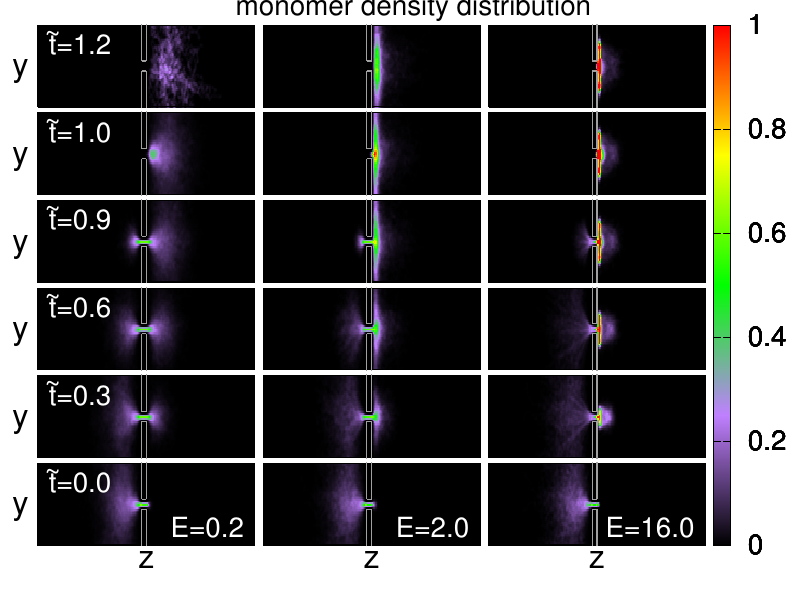
Figure 11. Density distributions of monomer, viewed along x -axis, at (Left) E = 0.2, (Middle) E = 2.0, and (Right) E = 16.0. The chain length is N = 128. The value of ˜ t is indicated in the